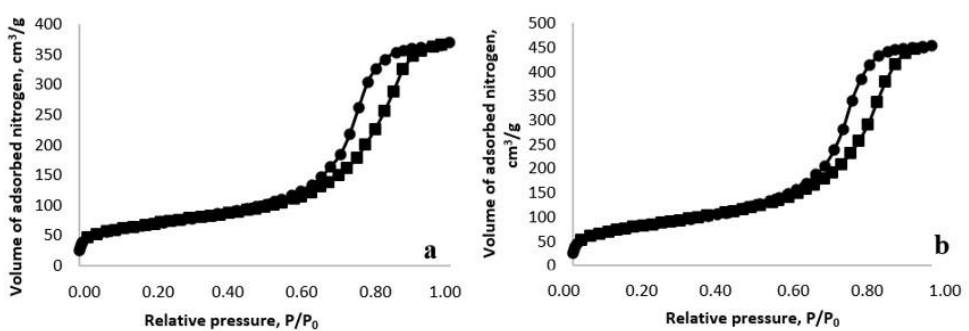
Figure 5. Curve sorption—desorption of nitrogen on the catalyst: ( a ) PMo1, ( b ) SA.